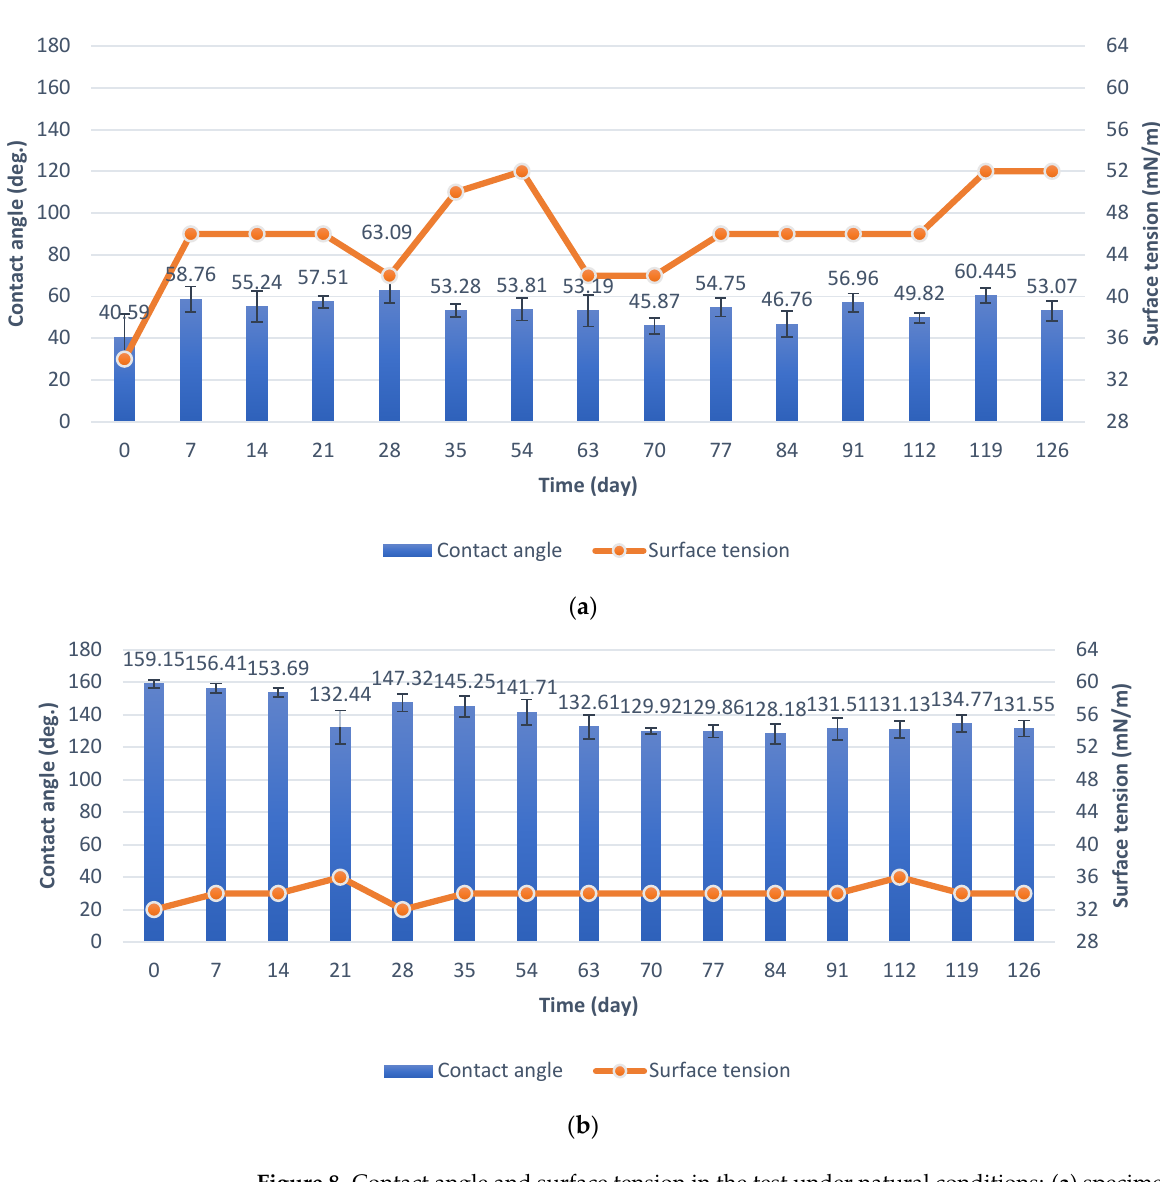
Figure 8. Contact angle and surface tension in the test under natural conditions: ( a ) specimens from Series 1; ( b ) specimens from Series 2.